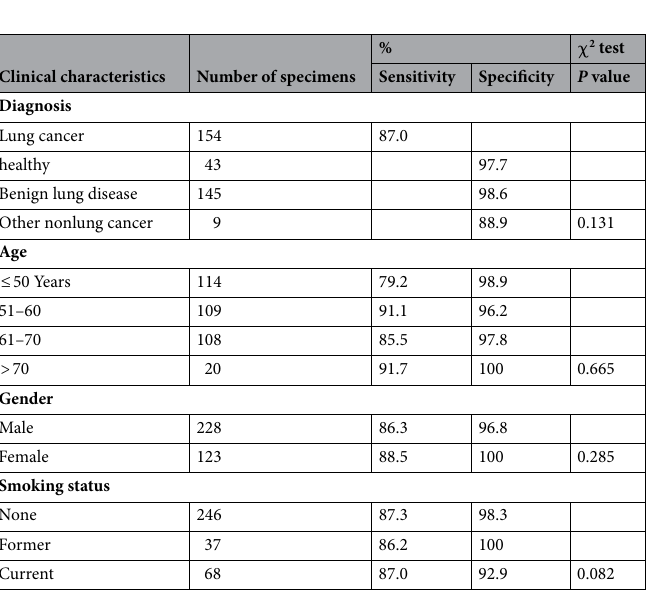
Table 4. Overall performance of the panel in diverse demographics characteristics of the population.